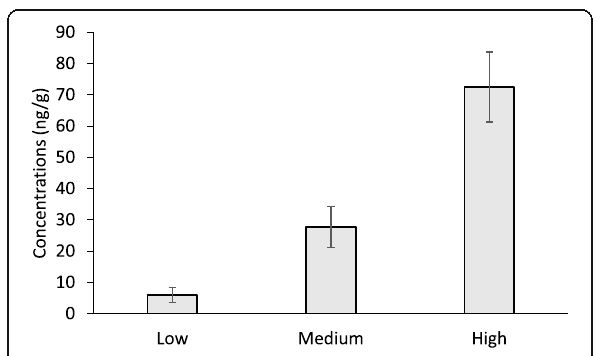
Fig. 9 P-bi-TAT levels in the brain of rats ( n = 4) at low (1 mg/kg), medium (3 mg/kg), and high (10 mg/kg) doses. Error bars represent standard errors of the